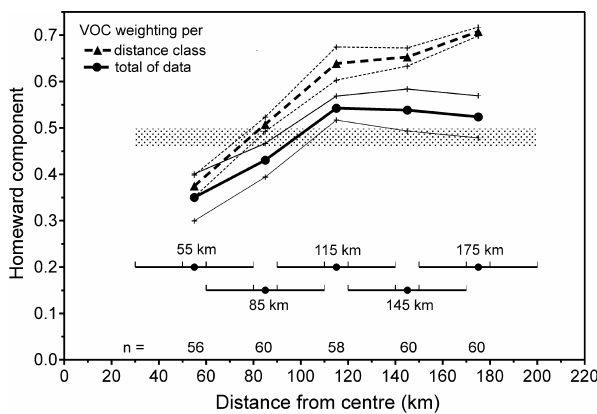
Fig. 5. Dependence of homeward orientation on distance from the centre. Means ( ± 99% confidence limits) of uppermost 10 of 100 homeward components c H obtained with air data collected within varying distance ranges as indicated (8 sites per distance as marked by an upwards dash, 64 air samples per distance class). The broken- line results were achieved with separate optimisations per distance class starting with standardised VOC weights around 1. The solid- line calculations used VOC weightings achieved with the total data set ranging from 30 to 200km and now applied to the respective distance class. Sample sizes n of actually usable CGMs are given on the bottom. The dotted area indicates the c H range of the uppermost 10% ItRuns summarising data of all 96 sites together.